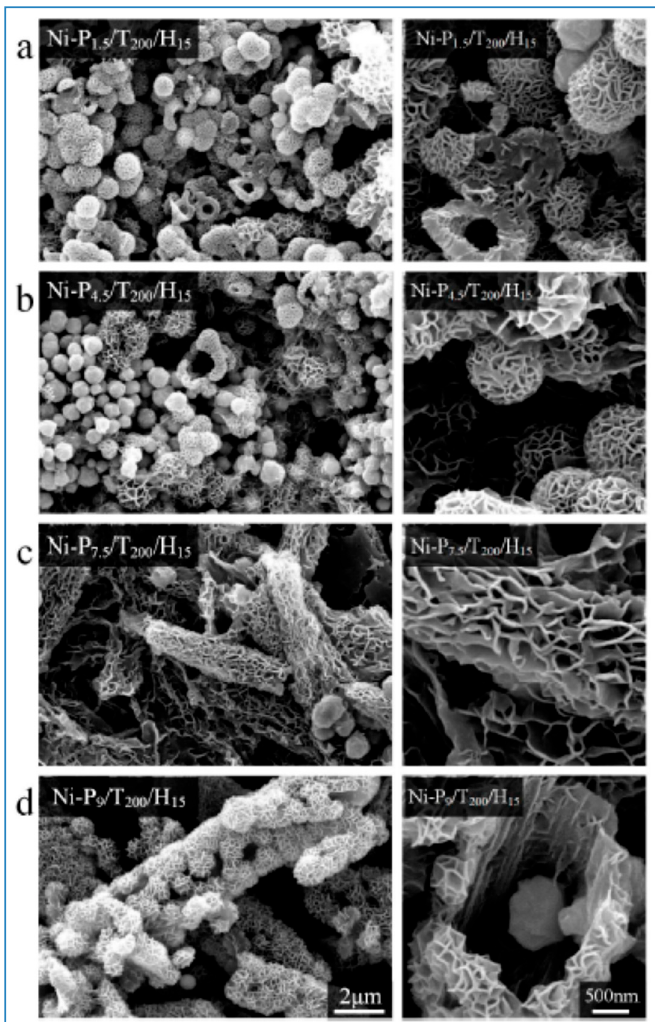
Figure 8. SEM images of Ni-P 1.5 / T 200 / H 15 ( a ); Ni-P 4.5 / T 200 / H 15 ( b ); Ni-P 7.5 / T 200 / H 15 ( c ); and Ni-P 9 / T 200 / H 15 ( d ) powders. The scale bars apply to all images in a column. Reproduced from [141] in Materials published by MDPI.